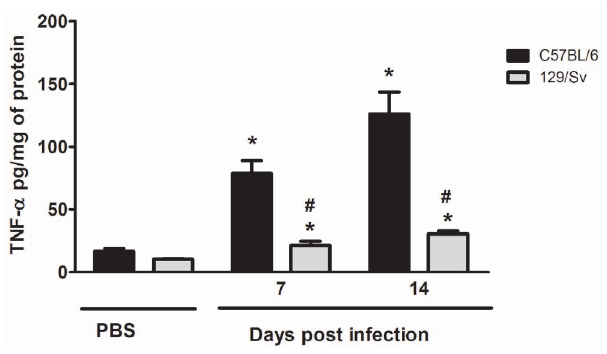
Figure 3. TNF- a production in lung of resistant (129/Sv) and susceptible (C57BL/6) mice. Lungs were removed at 7 and 14 days after i.t. injection of PBS or 5 6 10 5 H. capsulatum yeast cells. TNF- a levels were determinate by ELISA. Data are presented as the mean 6 SEM and are representative from one of two independent experiments (n=6/ each experiment). * 129/Sv compared with C57BL/6; # 129/Sv H. capsulatum compared with C57BL/6 H. capsulatum . p , 0.05 vs. PBS.